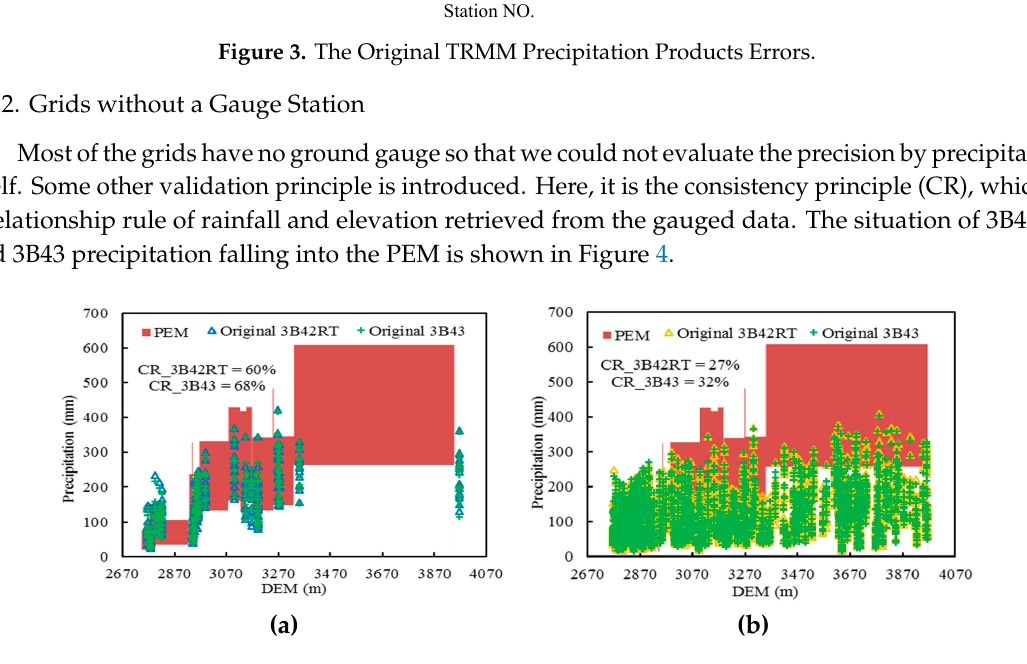
Figure 4. The gauged precipitation – elevation mask (PEM) and original TRMM precipitation filter from 2001 to 2016. ( a ) Grids with gauge station. ( b ) Grids without gauge station.